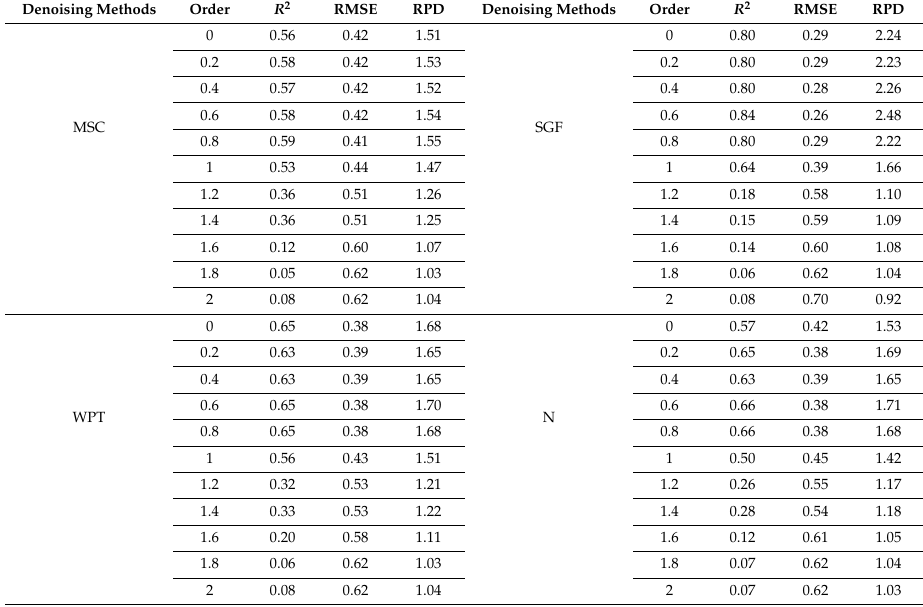
Table A2. SOM Content Estimation Model Results through MDS dimensionality reduction. DenoisingMethods Order R 2 RMSE RPD